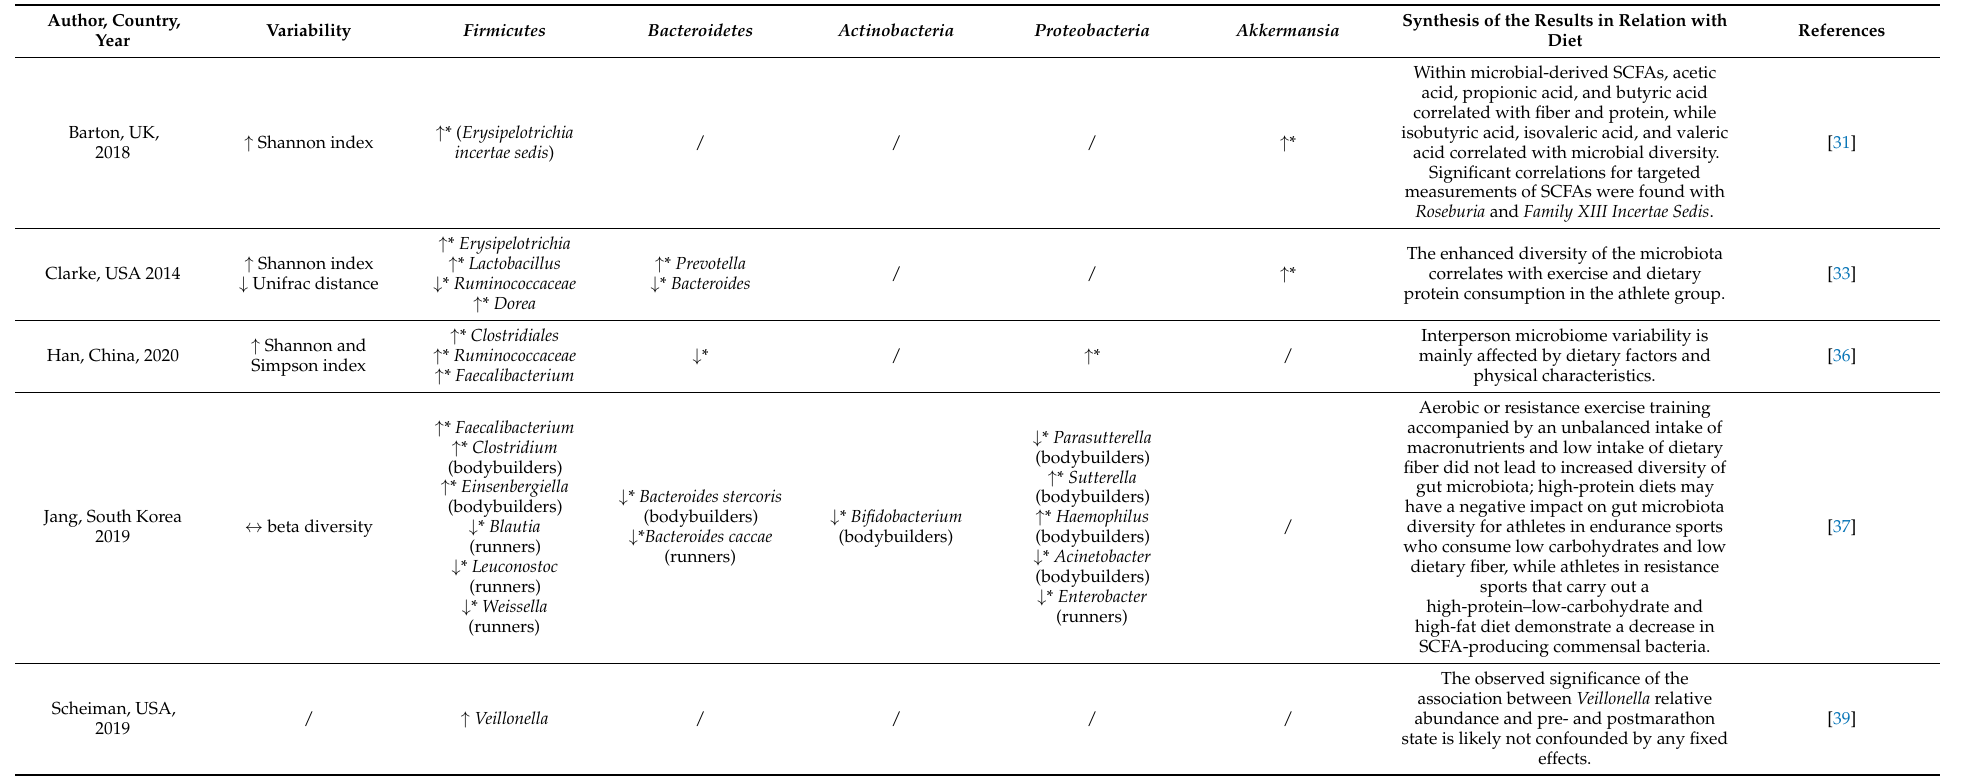
Table 2. Main findings related to gut microbiota variability and composition in athletes compared to inactive controls from the selected